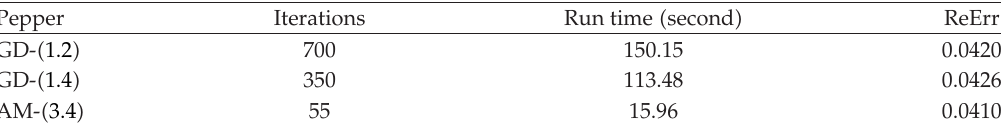
Table 2: Number of iterations, computational time, and ReErr of the three methods for the results in Figures 3 and